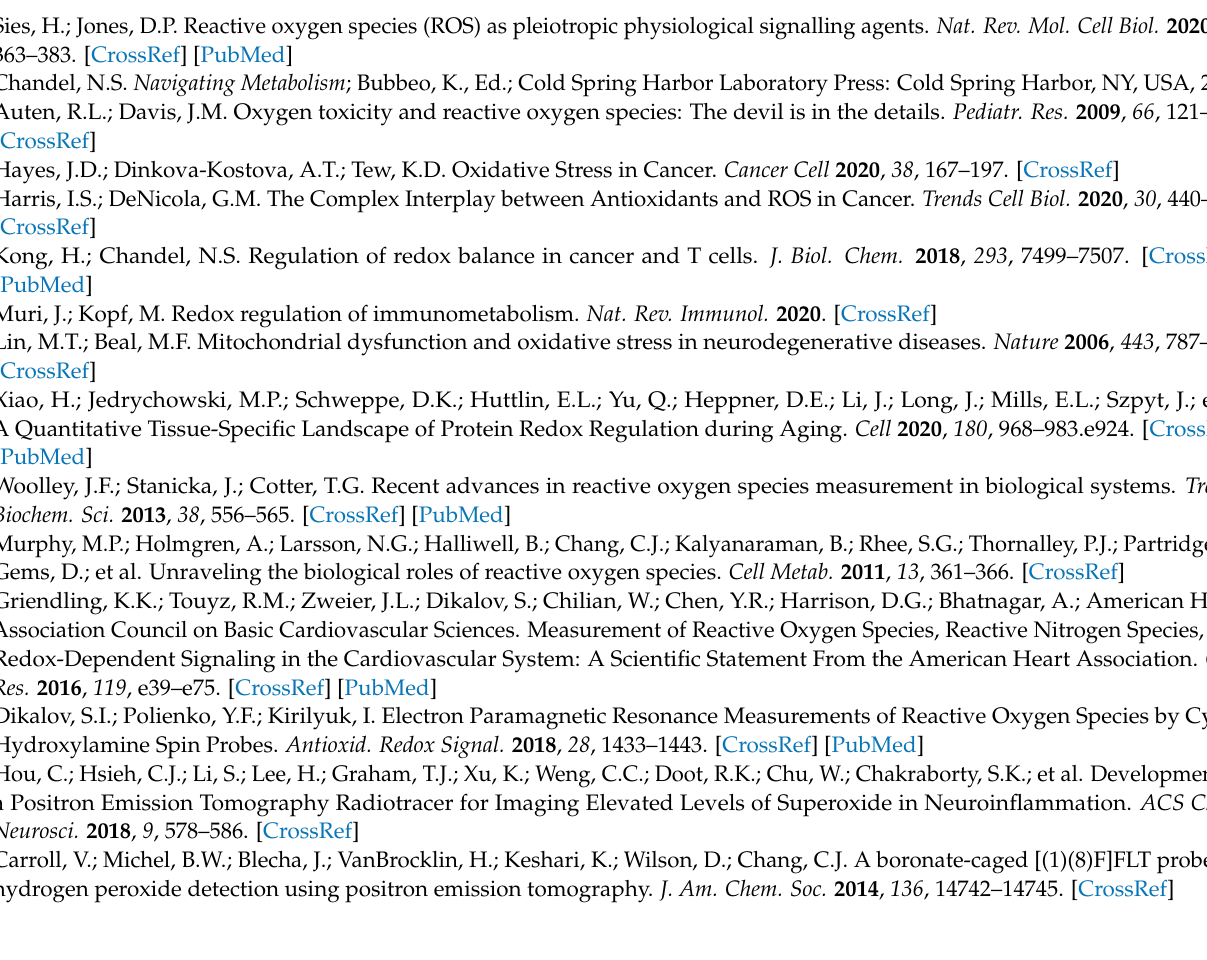
balance, Table S1: Standards and retention times, Table S2: Column comparison, Table S3: Tissues buffer comparison, Table S4: K562 buffer